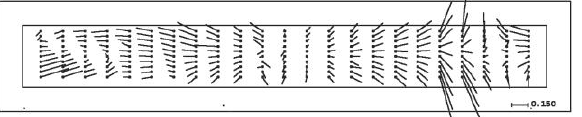
Figure 11. Correction grid forward camera, image F57